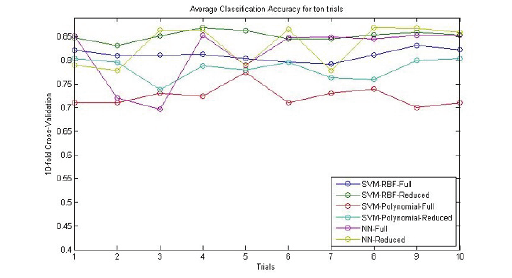
Fig. 1. Result of ten trials for multi-class IC packaging type classifier.